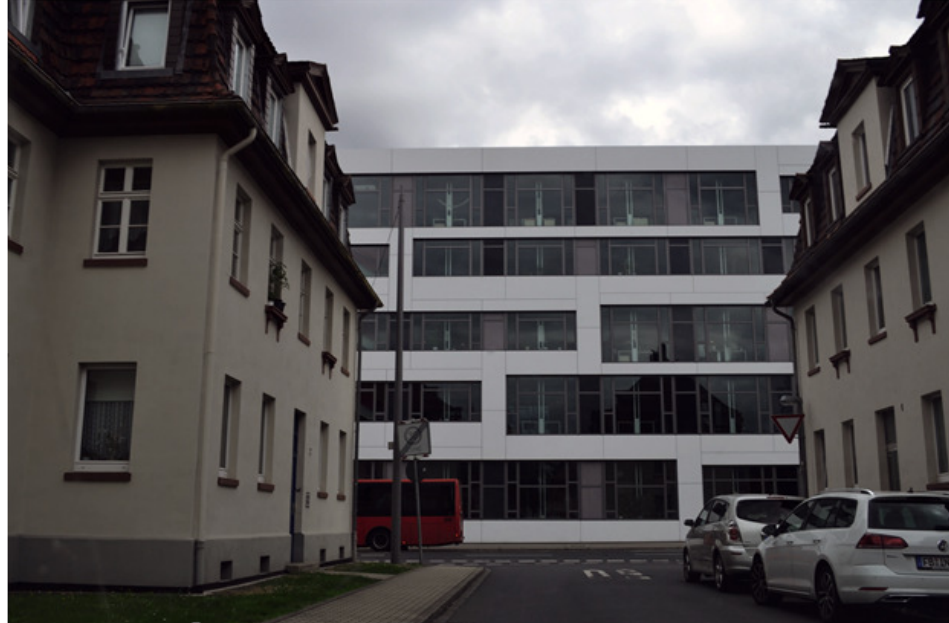
Figure 5. Kassel‐Bettenhausen old residential area and new industrial area. Source: Charlotte Reiher. both functionally and structurally, between residential and small‐scale building structures on the one hand and commercial and large‐scale development on the